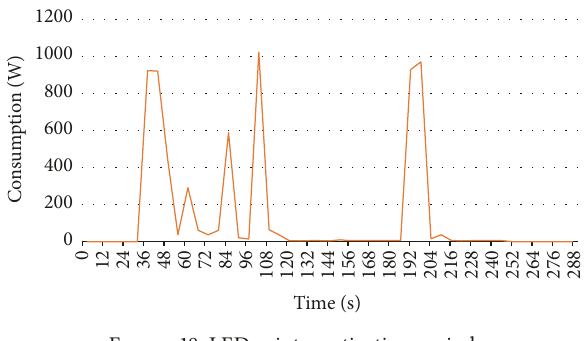
Figure 18: LED printer activation period.